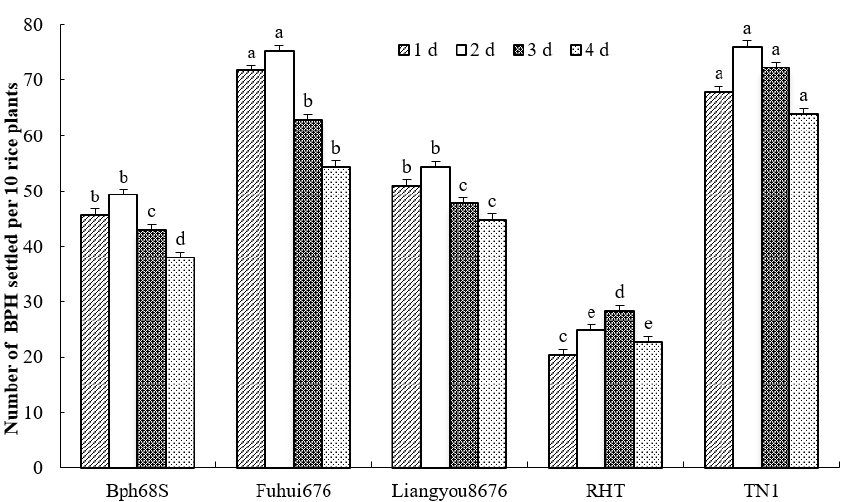
Figure 2. Host feeding choice of BPH on rice. Bar graph represent the number of BPHs settled on seedlings of different rice lines. Error bars indicate standard deviation. And bars labeled with different letters indicate the significant difference ( p < 0.05, one-way ANOVA, LSD multiple comparison).